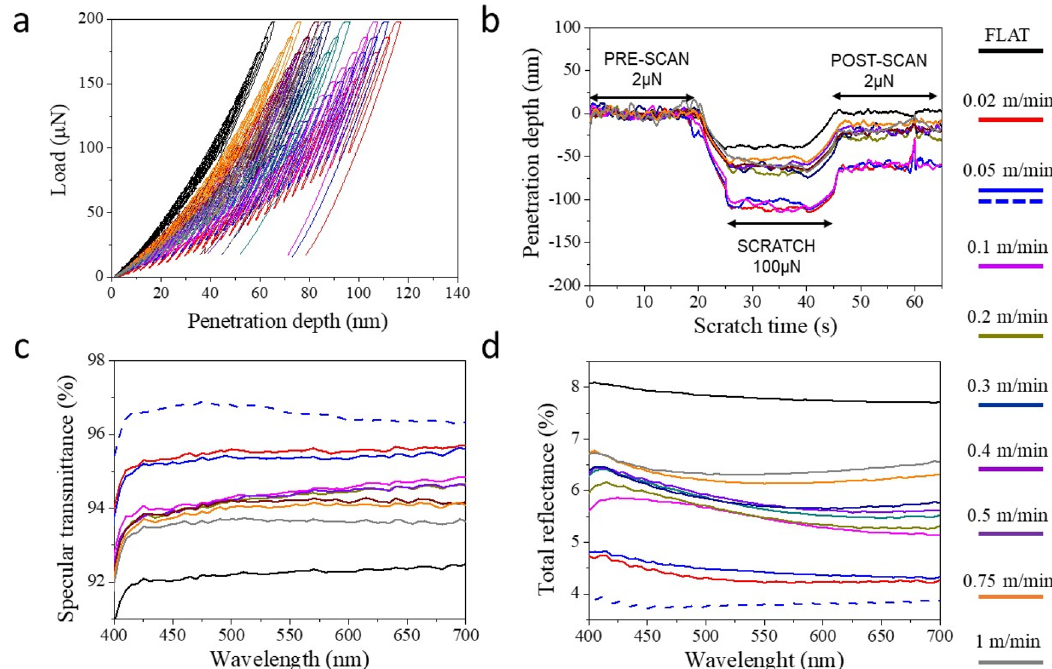
Figure 8. ( a ) Representative nanoindentation loading–unloading curves obtained for the nanoimprinted moth-eye films processed at 110 °C and at different web speeds. ( b ) Representative nanoscratch measurements obtained for normal applied load of 100 µN. Broadband optical performance of the R2R nanoimprinted substrates: ( c ) specular transmittance spectra and ( d ) total reflectance spectra. The dotted line corresponds to a two-sided nanoimprinted moth-eye PMMA film prepared at 110 °C and 0.05 m·min −1